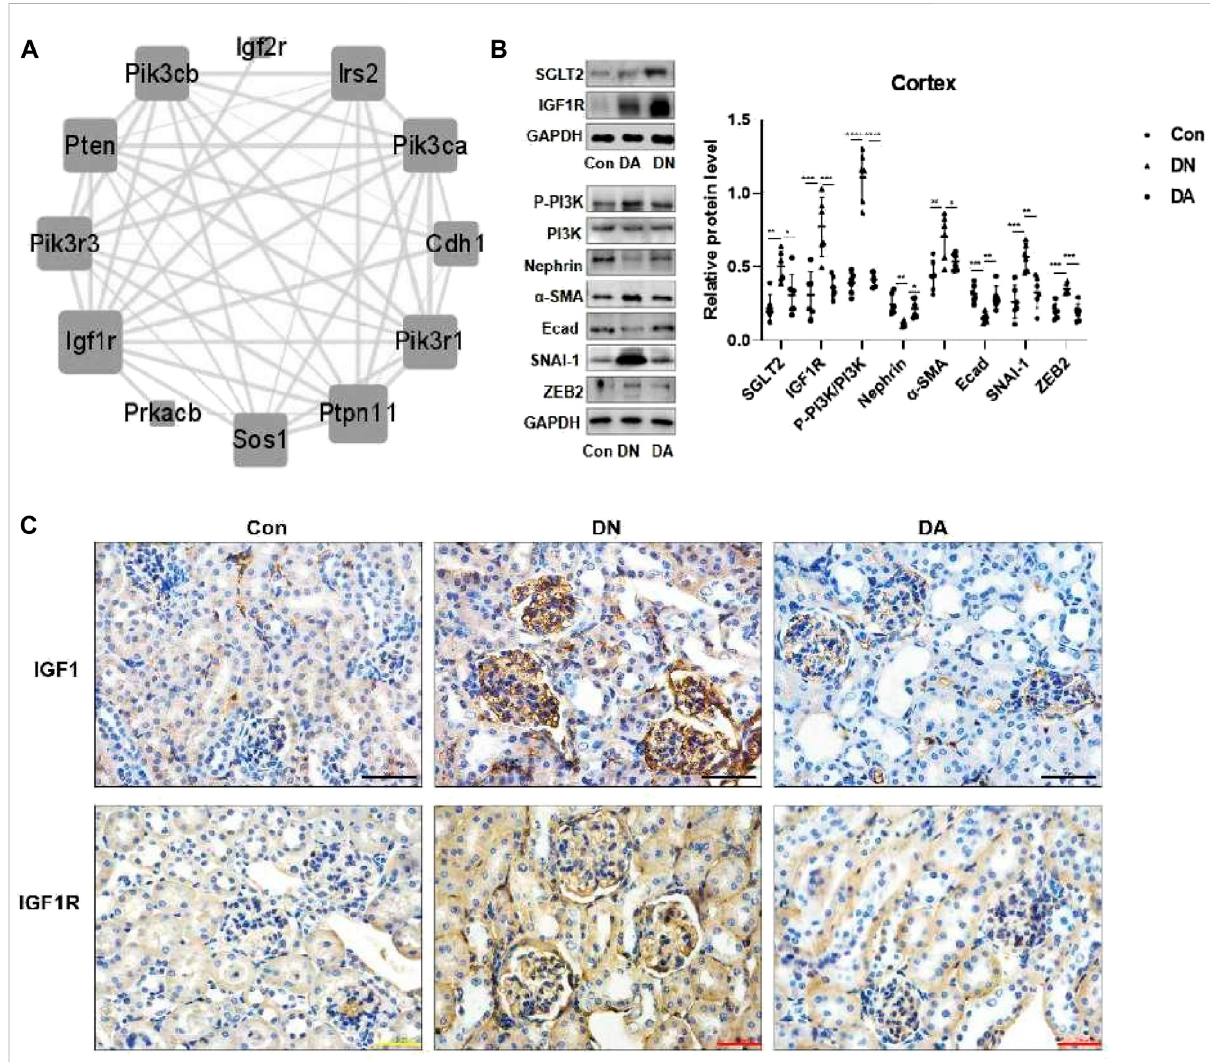
FIGURE 3 In DN models, upregulation of SGLT2 activated IGF1R/PI3K signaling. (A) IGF1R-centered PPI network (combined score > 0.9). (B) Protein expression levelsofSGLT2,IGF1R,phosphorylatedPI3K, andEMTmarkers wereanalyzed using Westernblotting.The data wereanalyzed byANOVA with Tukey ’ s post hoc test. (C) IHC images of IGF1 and IGF1R. PPI: protein – protein interaction; * p < 0.05, ** p <